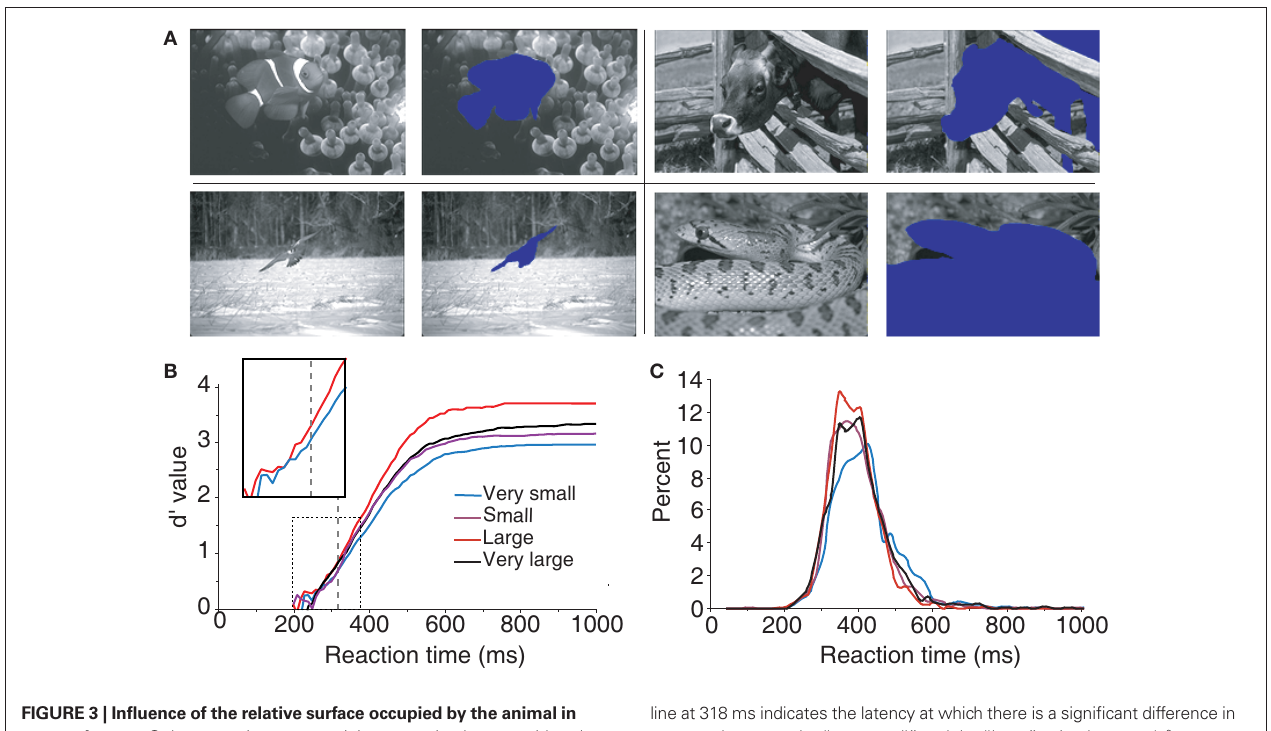
Figure 3 | influence of the relative surface occupied by the animal in target pictures. Only target pictures containing one animal are considered here. (A) Four examples of animals semi-automatically cut out of target pictures to calculate their surface in the picture (one for each size class “very small”, “small”, “large” and “very large”). (B) Dynamic d ′ plots (see Materials and Methods) showing how subject accuracy varied over time for the four groups of images containing animals of increasing sizes). The vertical dashed